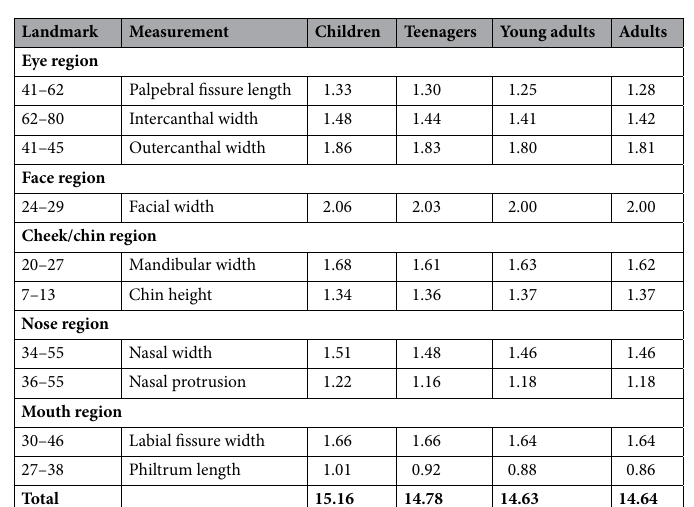
Figure 3. PCA and visualization. ( A ) Distribution of specimen in morphospace along PC1 versus PC2. ( B ) Canonical variate analyses of the first axis plotted against the second axis. ( C ) Lollipop graphs associated with the first PC of shape variability for morphological differences between the average groups. ( D ) Heatmaps of TPS interpolations of local changes in facial regions based on each set of landmarks and semi-landmarks (the software Lori 1.0 32 was used to process the heatmaps).